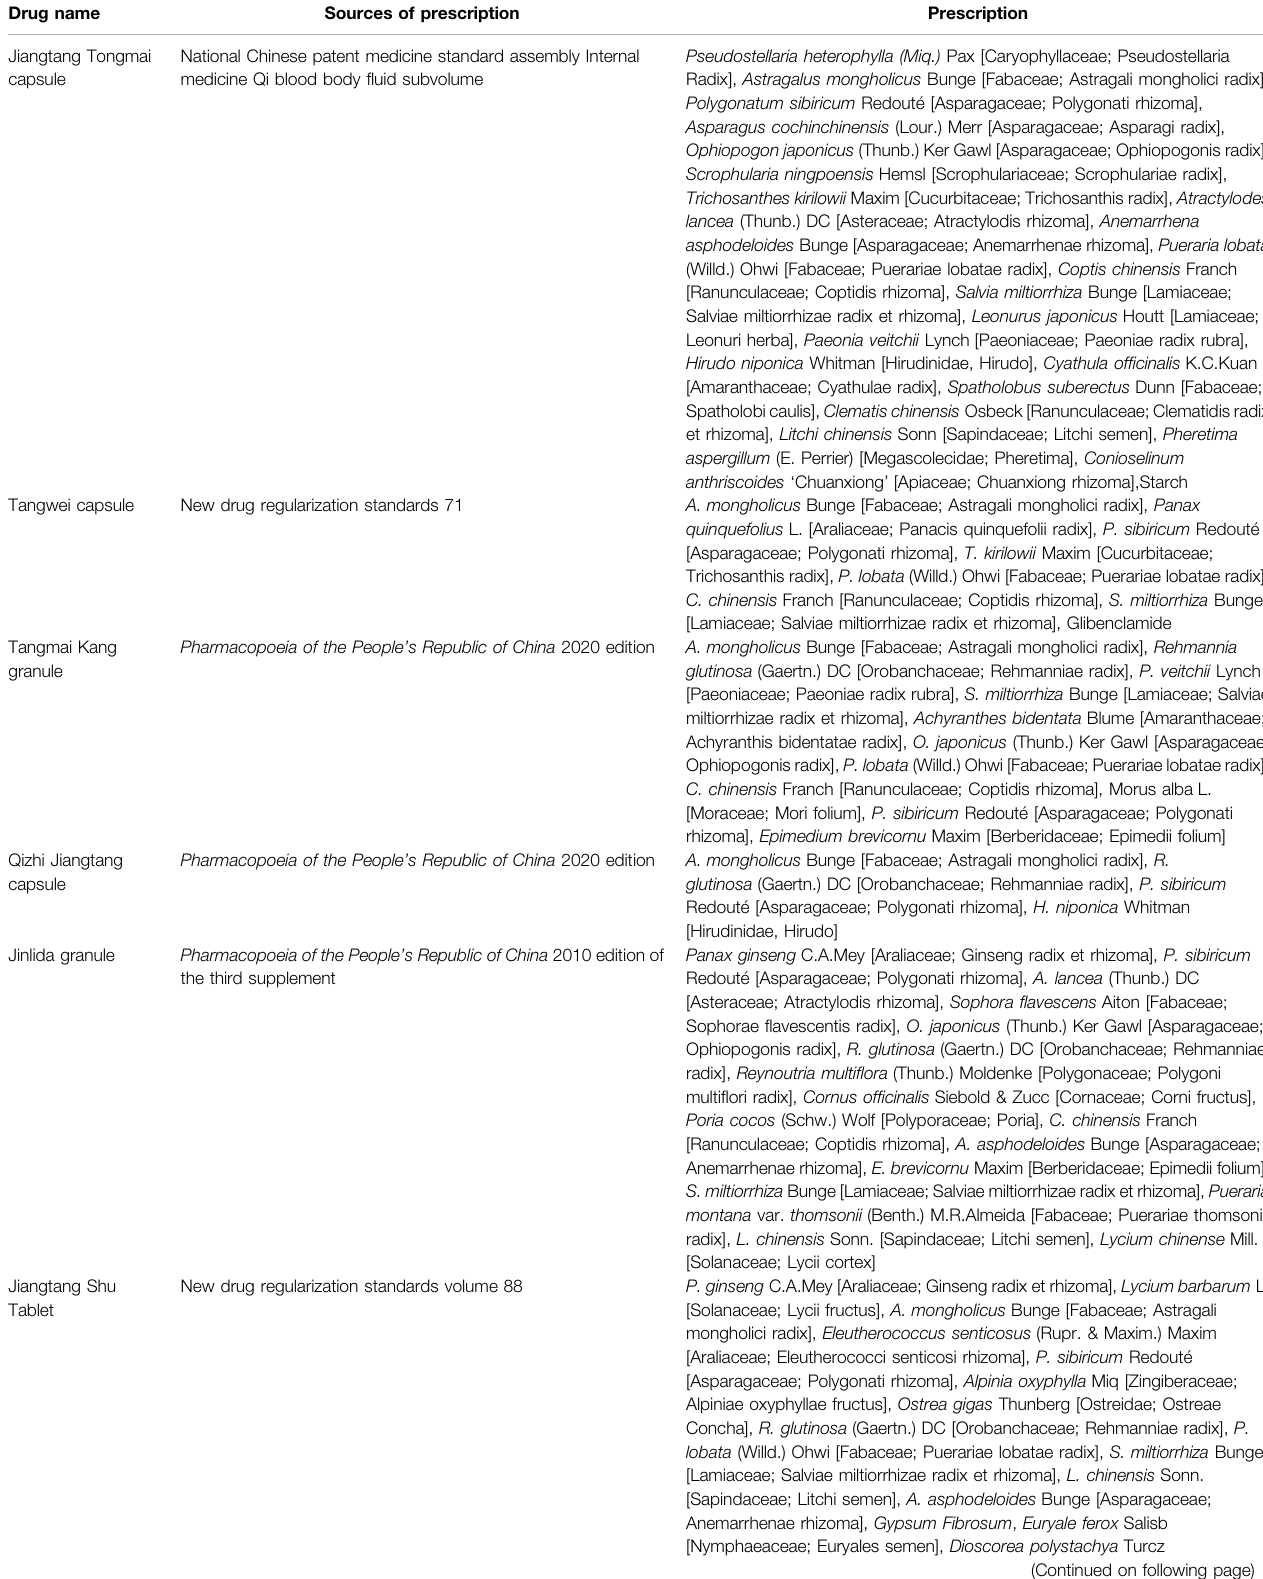
TABLE 5 | Chinese patent medicine prescription containing Polygonatum with hypoglycemic effect (data from db.yaozh.com). Drug